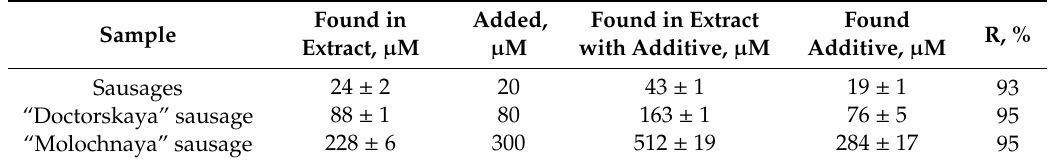
Table 3. Results of nitrite determination in sausage extracts by applying the TrX100 / FCVE ( n = 3, p = 0.95) and the added-found method.